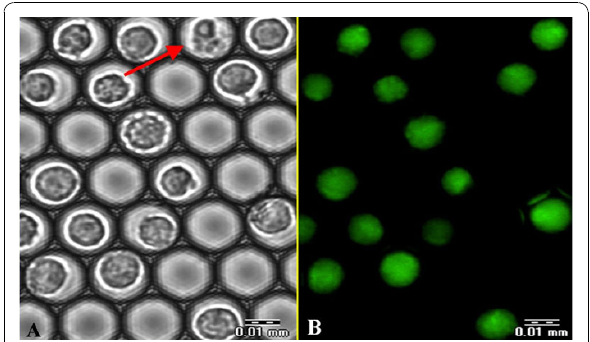
Figure 5 Monitoring U937 cell membrane integrity after the freezing - thawing cycle by FDA staining . The U937 cells were exposed to the freezing - thawing cycle in the i3C. At 3 hours after thawing, FDA solution (1.2 μ M) was introduced into the i3C and images were taken 5 minutes after FDA addition. The transmitted image (A) and corresponding fluorescent image (B) are presented. The dead U937 cell unstained by FDA is indicated by the red arrow. Scale bar: 0.01